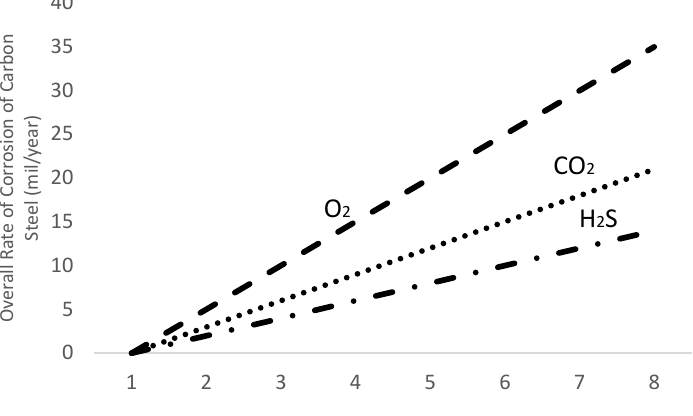
Figure 2. Comparison of rusting rates of three gases [27].